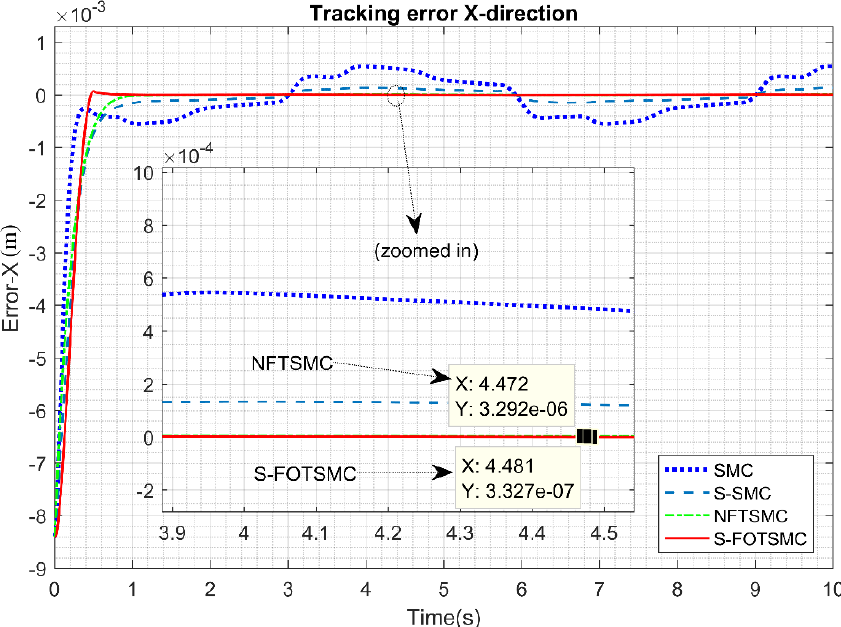
Figure 4. The tracking errors of the end-effector in the X-direction.